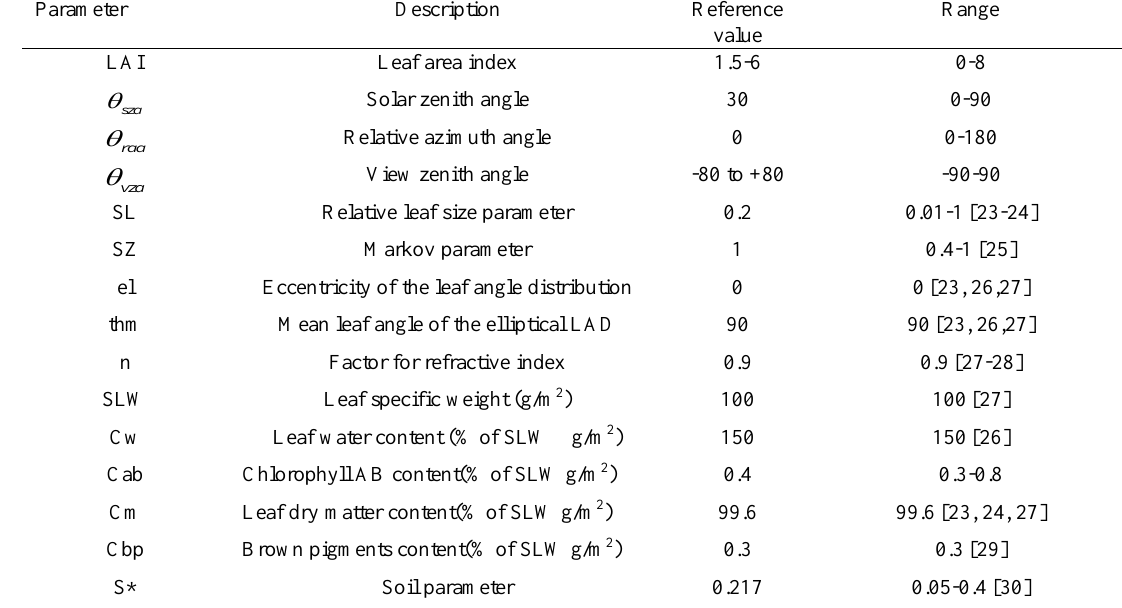
Table 3. Input parameters for the ACRM model